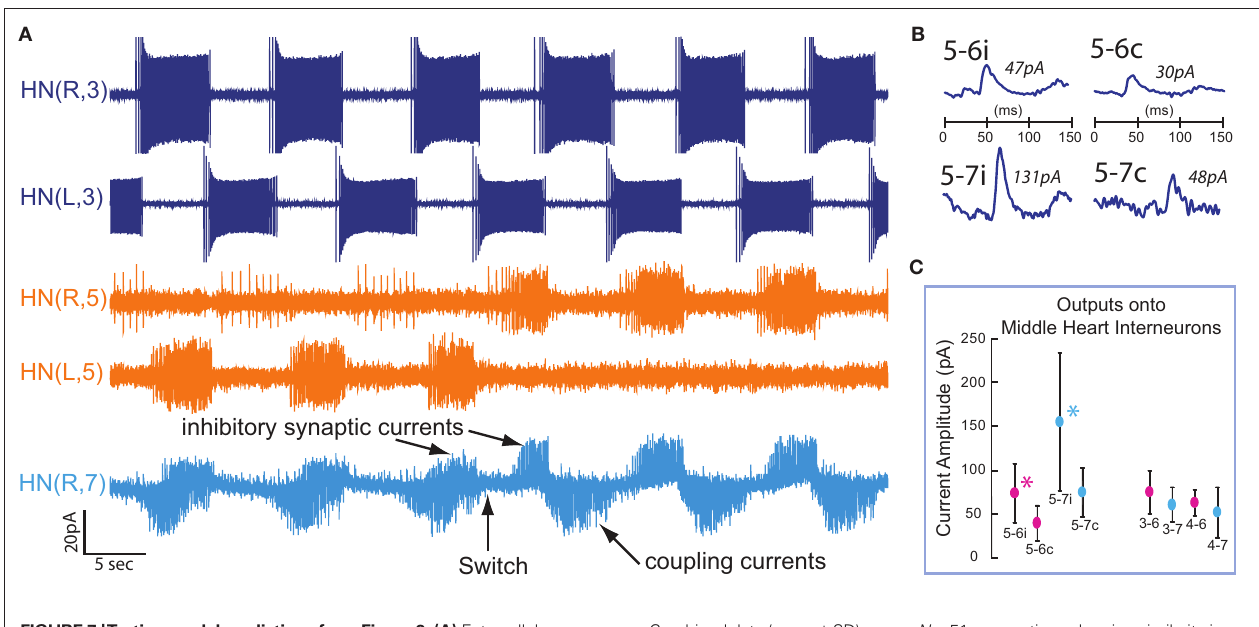
Figure 7 | Testing model predictions from Figure 3 . (A) Extracellular recordings from both HN(3) and HN(5) interneurons and a voltage-clamp recording from a HN(R,7) middle premotor interneuron. A switch is illustrated in which the left active switch interneuron becomes silent as the right silent switch interneuron becomes active. Note how the envelope of inhibitory synaptic currents increases in the HN(R,7) interneuron when the HN(R,5) interneuron becomes active while the envelope of coupling currents remains similar. (B) Spike-triggered average inhibitory synaptic currents in an HN(6) and an ipsilateral HN(7) heart interneuron evoked by both ipsilateral and contralateral HN(5) interneurons. Data are shown from the same preparation as in (A) . (C)